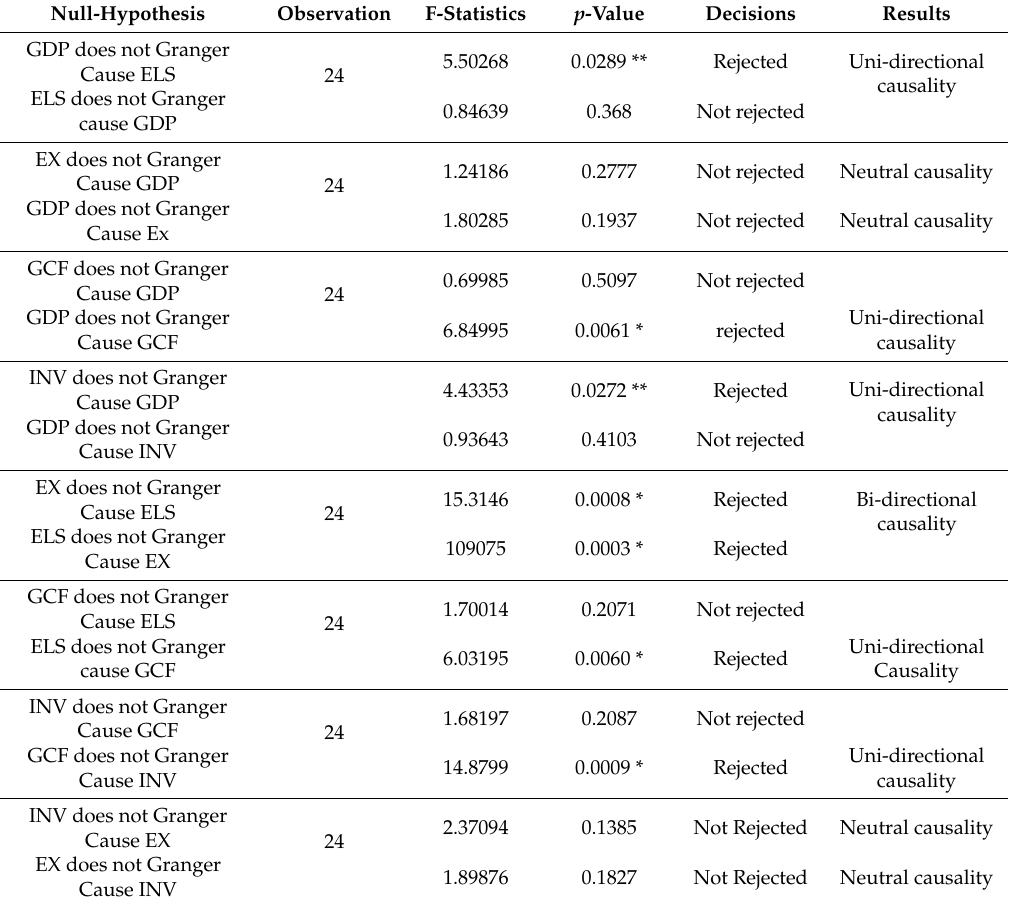
Table 7. Results from the pairwise Granger causality